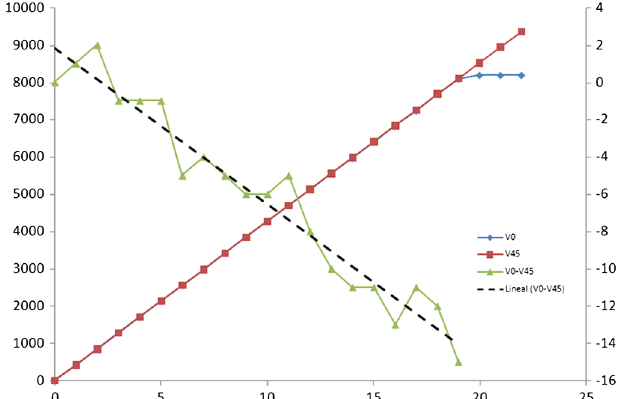
FIG. 5. Comparison between the IQ demodulator linearity with input phase set to 0 (cid:2) and 45 (cid:2) . The horizontal axis shows the input voltage in mV RMS . The vertical axis on the left shows the ADC counts corresponding to the two measurements and the one on the right the difference between the two waveforms.